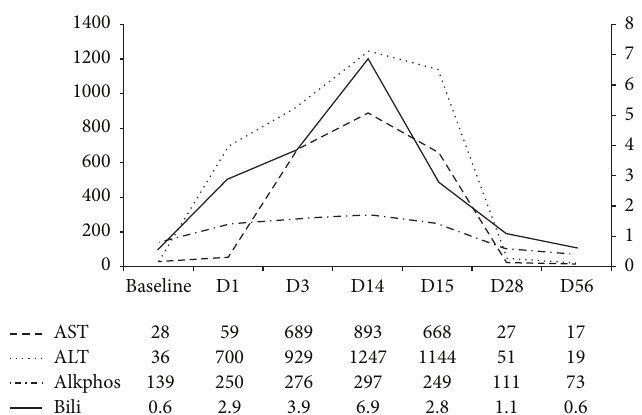
Figure 1: The graph depicts the rise and fall of transaminases and bilirubin from the time of 8 weeks after presentation. The table below the graph shows the numerical values. ( 𝑌 -axis on left side is in IU scale and 𝑌 axis on right side is in mg/dL scale).